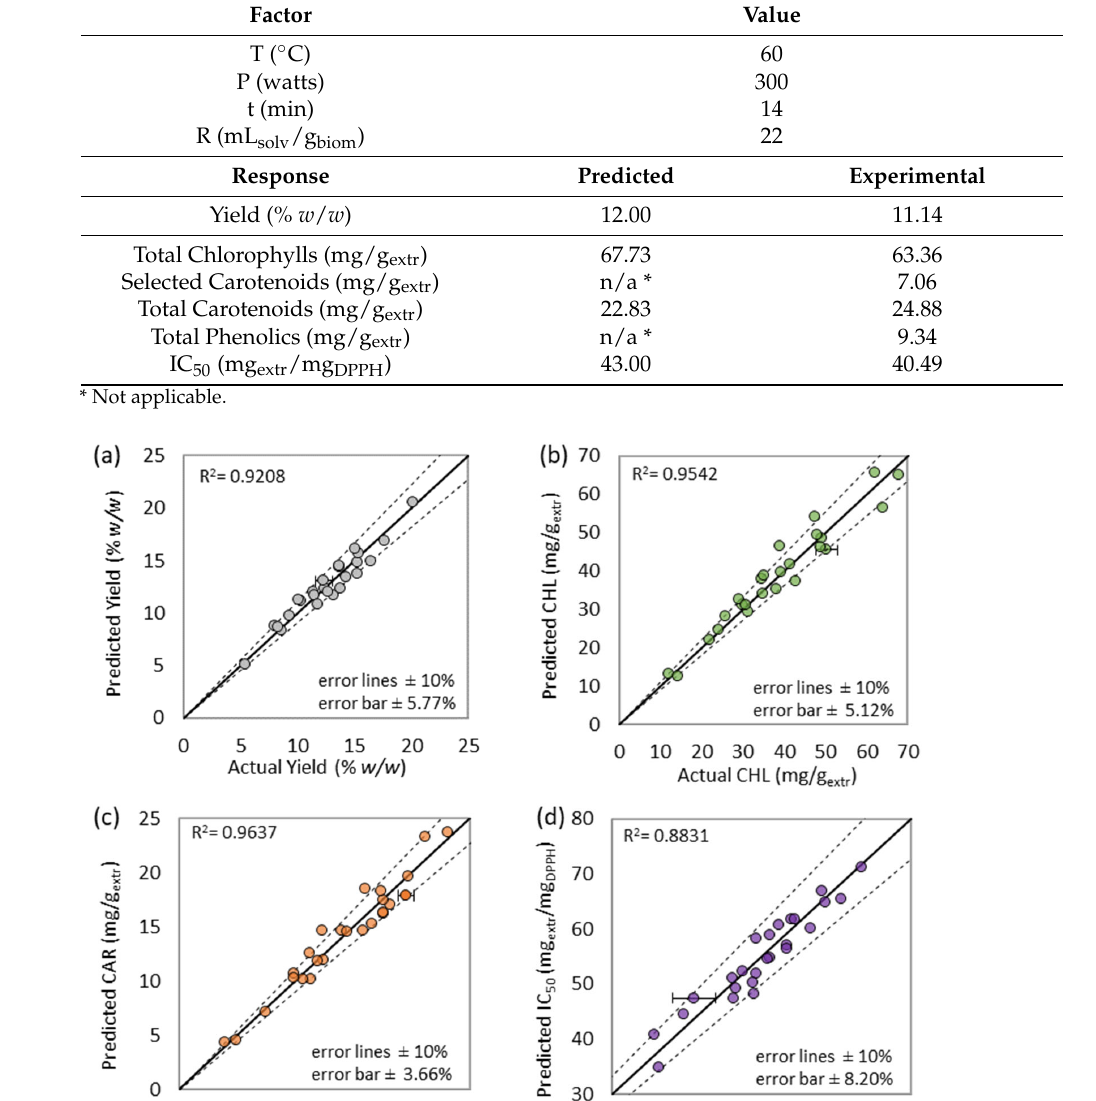
Table 3. Optimal MAE conditions of bioactive compounds from Chlorella vulgaris .